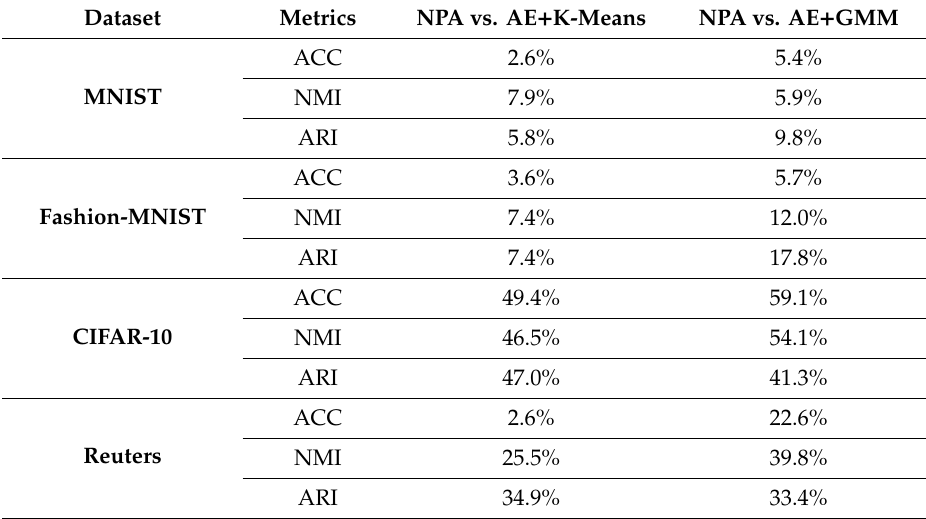
Table 3. Clustering performance of di ff erent algorithms on public